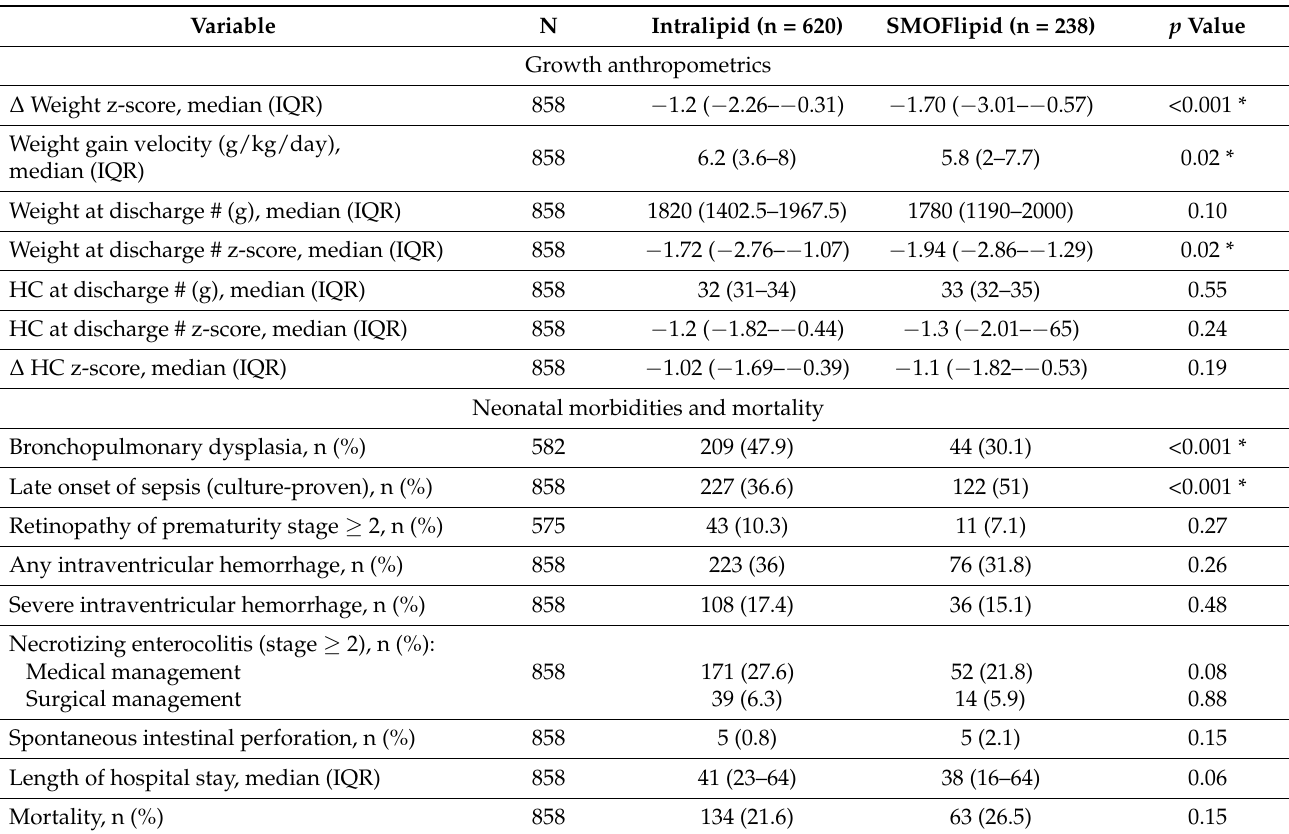
Table 3. Univariate analysis of growth anthropometrics, neonatal morbidity, and mortality stratified by type of LE.